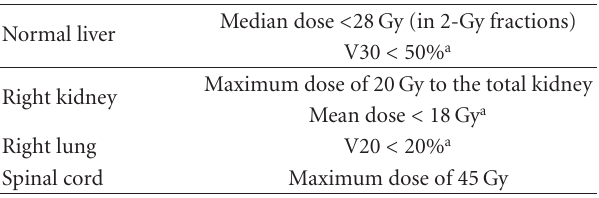
Table 2: Dosimetric constraints for each organ at risk: rec- ommended dose-volume limits from Quantec [15] and French guidelines